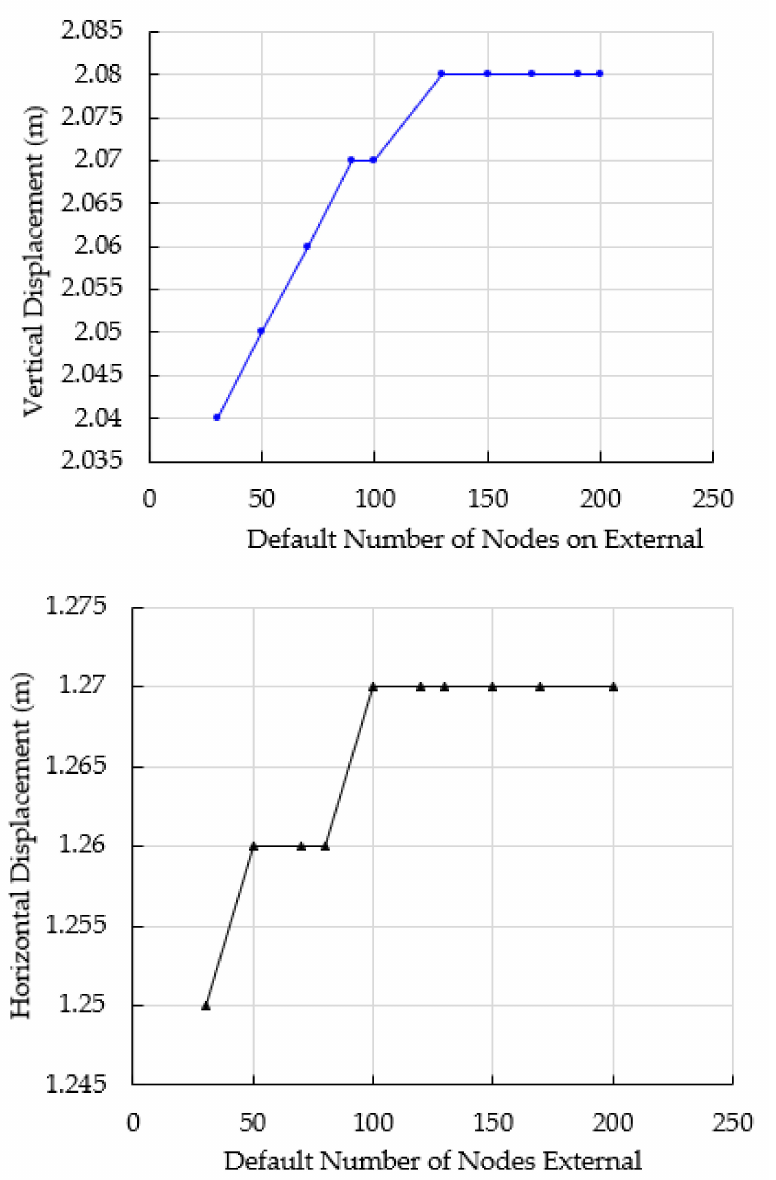
Figure 3. Mesh sensitivity analysis depicts the number of nodes on the external boundary versus vertical ( top ) and horizontal ( bottom )